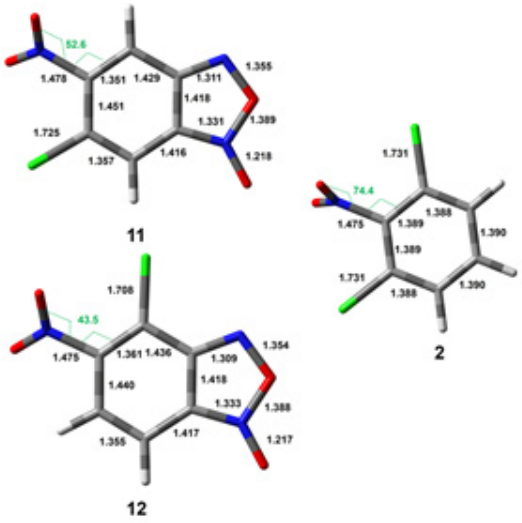
Figure 13. Optimized geometry of 11, 12, and 2 in solution.